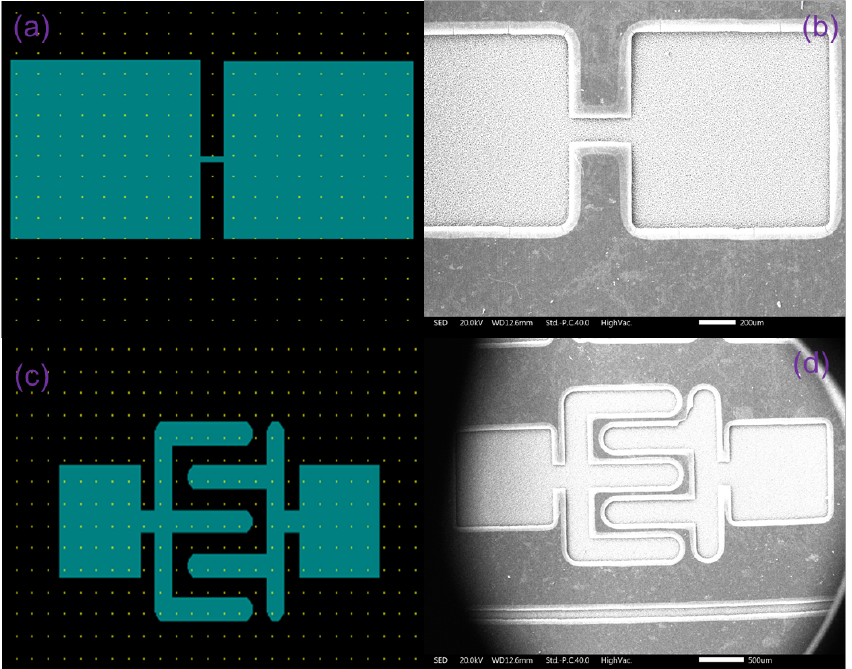
Figure 3. ( a ) CAD-mask file of a simple pattern. ( b ) SEM image of the final structure on FR-4 using the fabrication steps. ( c ) Pattern file of another geometry. ( d ) SEM image of the pattern in panel ( c ) procured on the